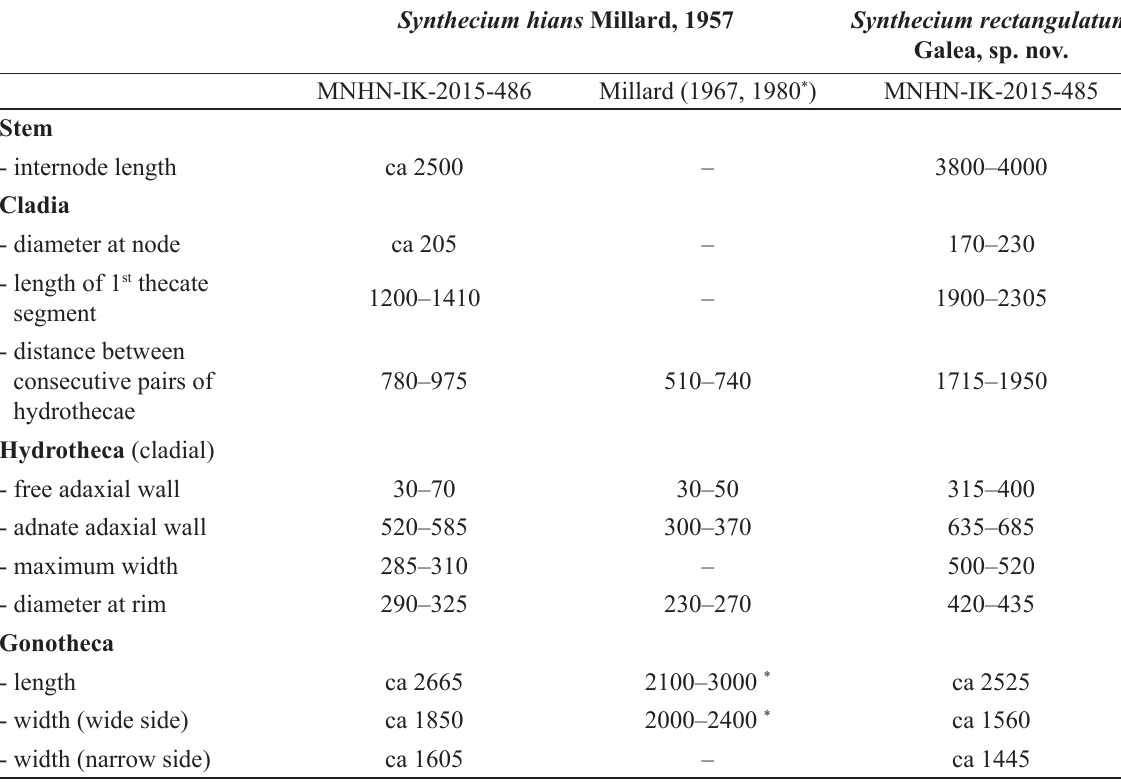
Table 4. Measurements of Synthecium spp., in